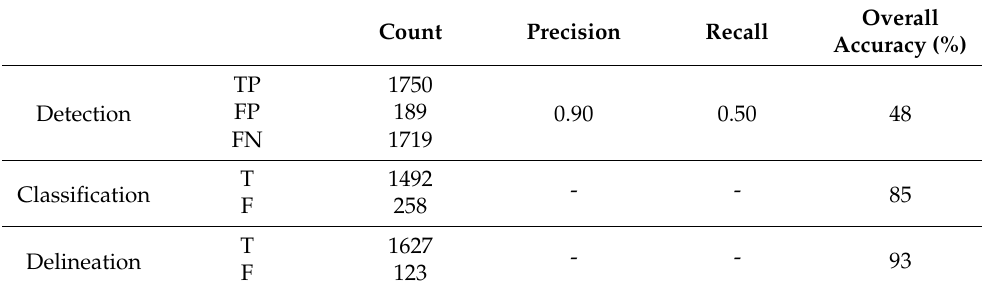
Table 3. Accuracy assessment for original images (1.2 m).